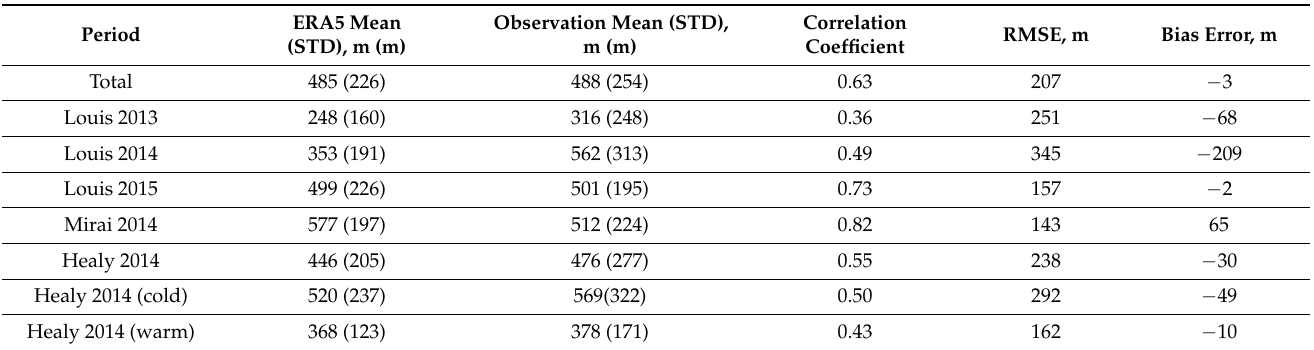
Table 1. Mean PBLH (m) from ERA5 and each